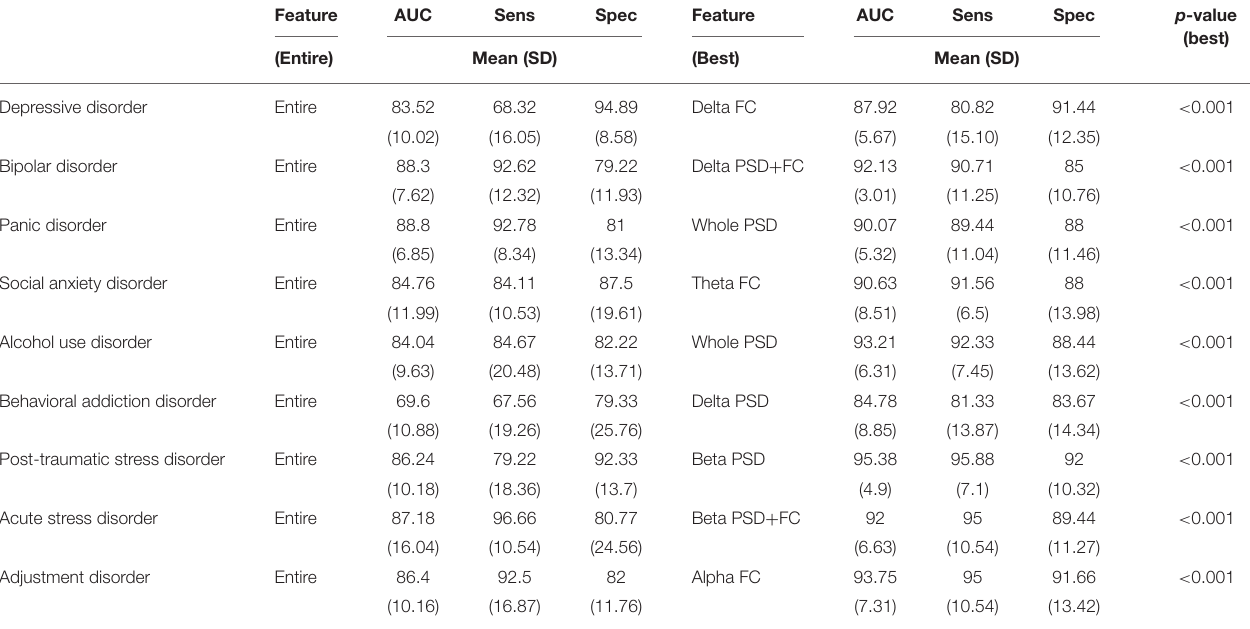
TABLE 3 | Comparison of models in predicting outcomes in patients with psychiatric disorders distinguished from healthy controls in specific diagnoses.